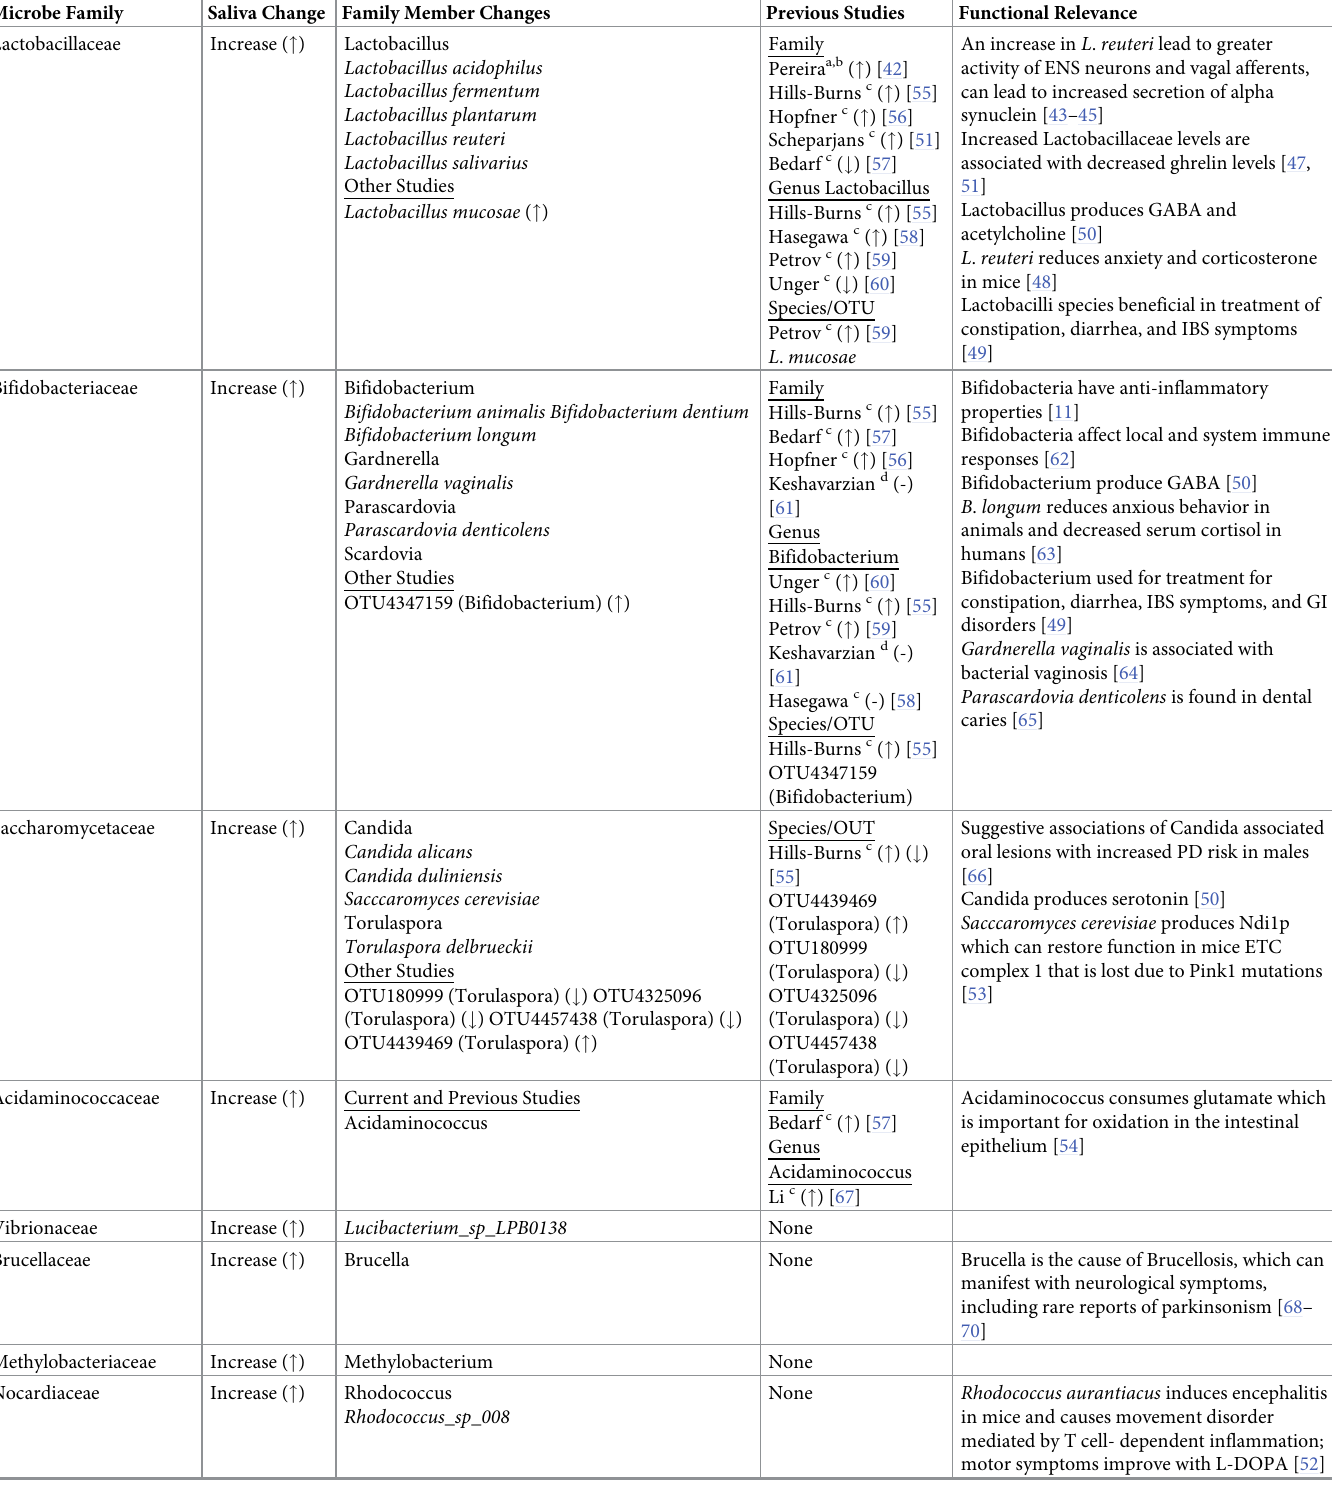
Table 7. Microbiota families altered in early stage PD in the present study and prior